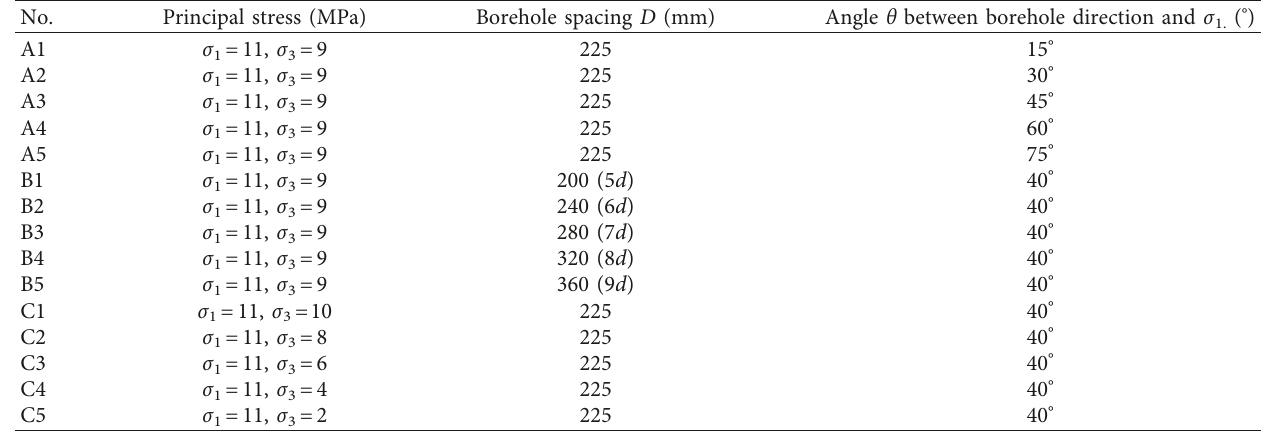
Table 4: Numerical simulation